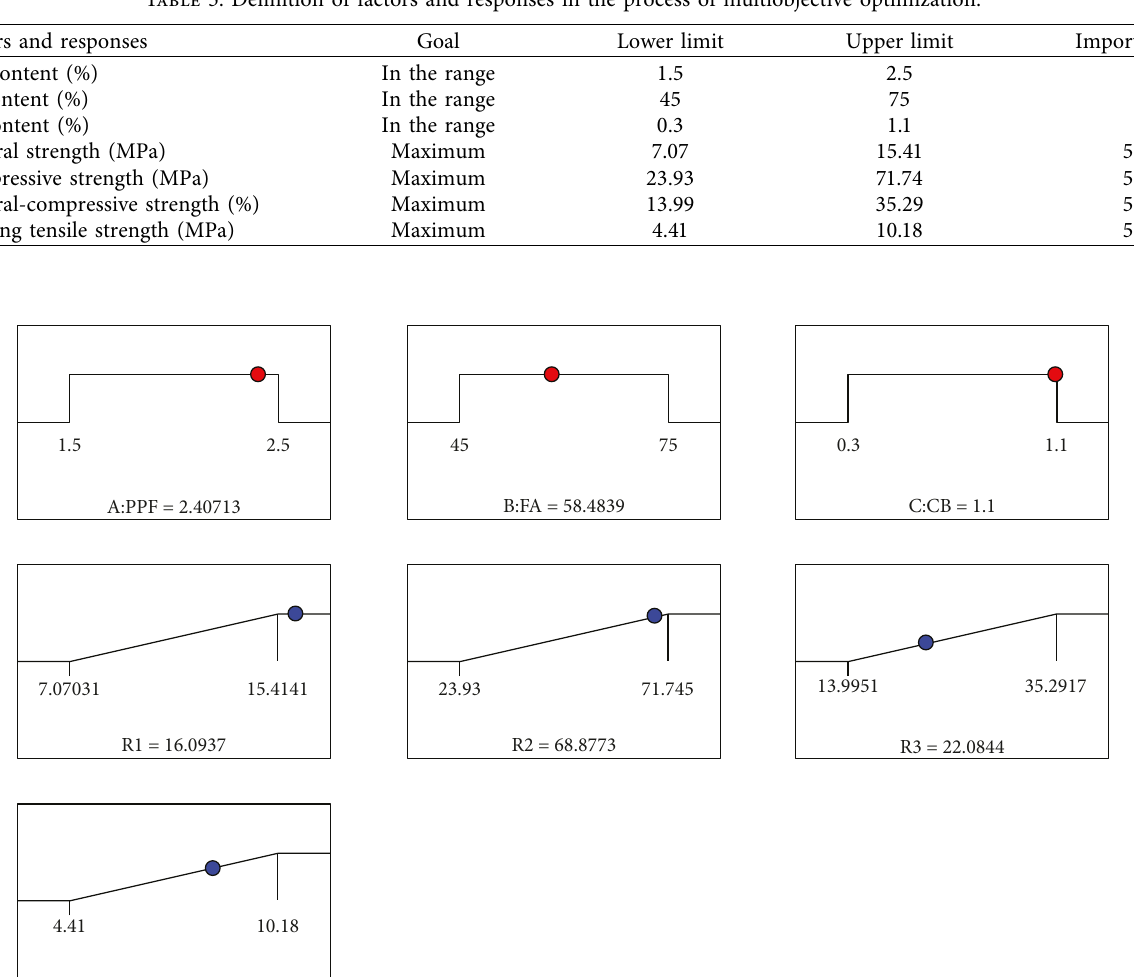
Figure 15: Change of expected value function based on the multiobjective optimization